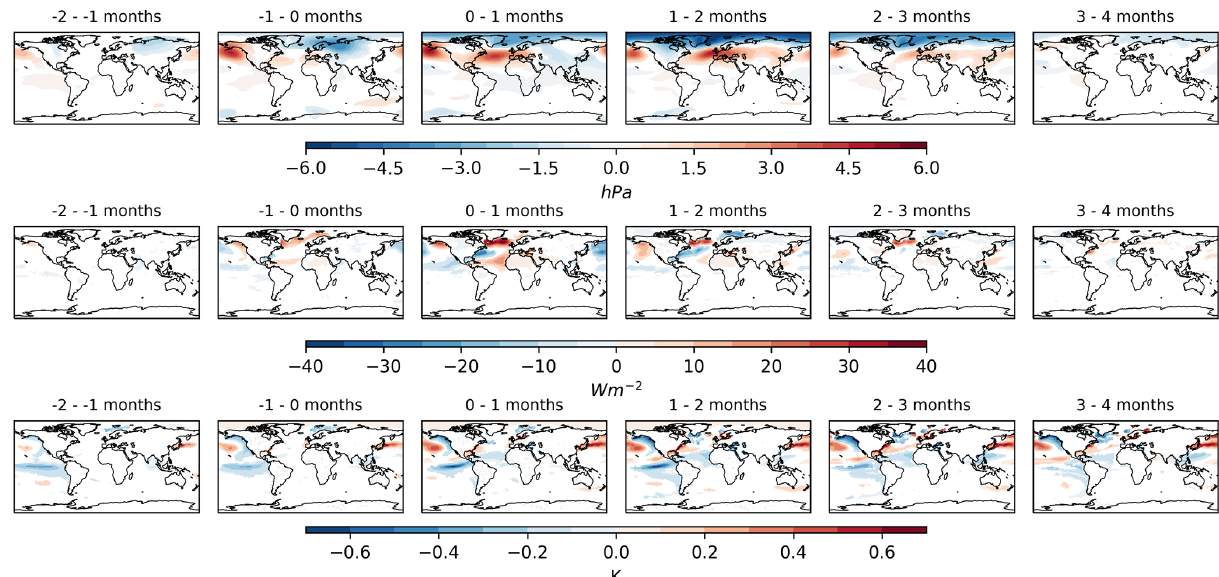
Figure 1. Surface patterns associated with anomalous winter stratospheric NAM 10 events. The top row shows the monthly mean sea level pressure anomaly (hPa), the middle row shows the ocean–atmosphere heat flux, defined as the sum of latent and sensible heat fluxes (Wm − 2 ), and the bottom row shows the SSTs (K). Coloured shading shows where the composite differences between strong and weak NAM 10 events are statistically significant at the 95% level under a two-tailed Student’s t test. The heading of each subfigure indicates the month range relative to the central date of each NAM 10 anomaly. Signals at negative times indicate that the surface anomaly leads the stratospheric NAM 10 anomaly. Signals at positive times indicate that the stratospheric NAM 10 anomaly leads the surface response.